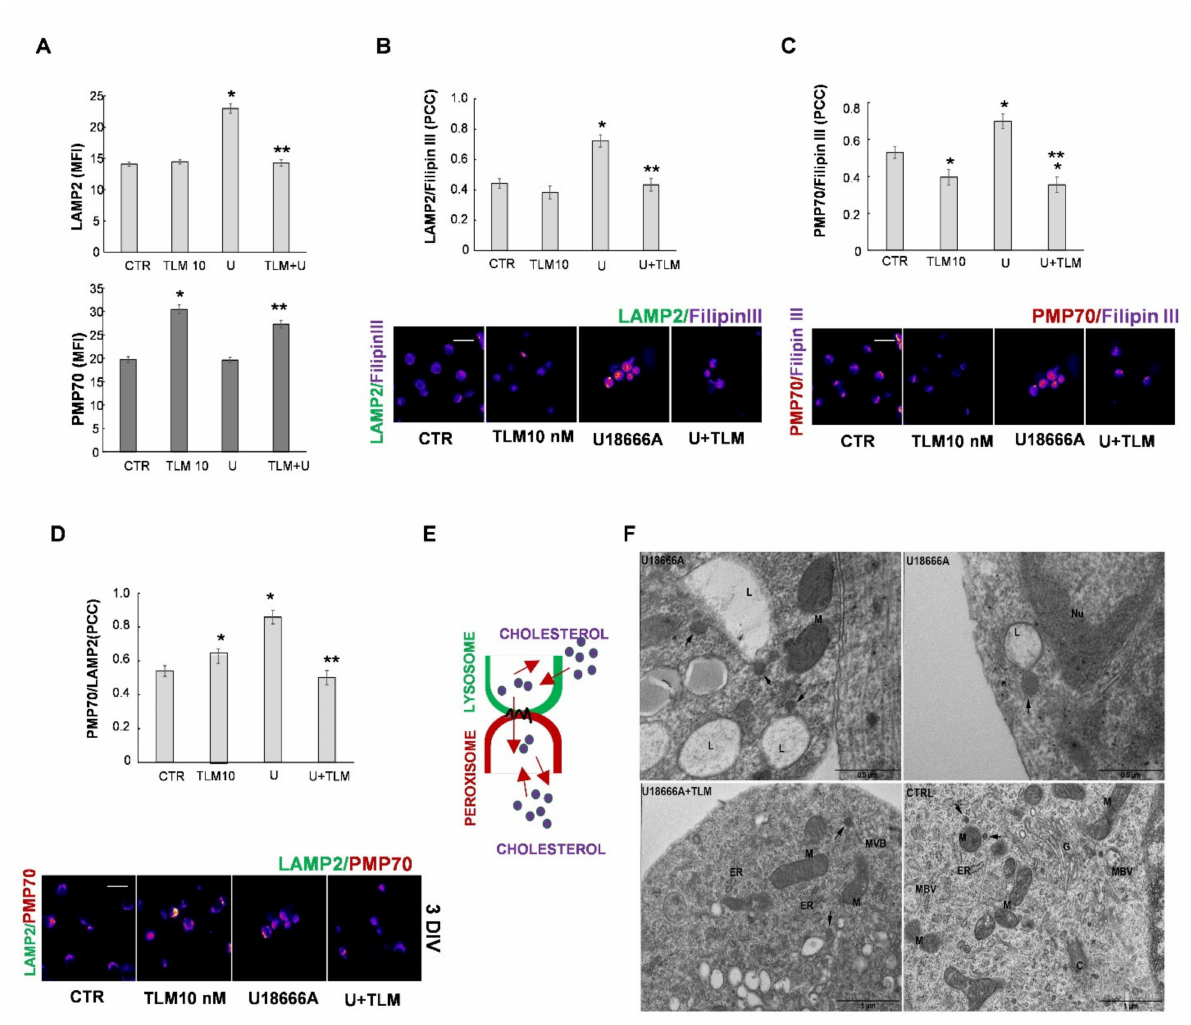
Figure 6. TLM modulates cholesterol traffic in lysosomes and peroxisomes. The lysosomal and peroxisomal levels were evaluated in OPs treated with TLM in the presence or absence of U18666A. The quantification of IF (MFI) of LAMP2 (lysosomal marker) and PMP70 (peroxisomal marker) is shown in ( A ). Data are Means ± SEM of 3 independent experiments (200–250 cells/condition; * p < 0.001 vs. CTR; ** p < 0.05 vs. U18666A, one-way ANOVA, unpaired two-tailed Student t -test). Colocalization of LAMP2/Filipin III ( B ) or PMP70/Filipin III ( C ) and LAMP2/PMP70 ( D ) were studied after 48 h of treatment with TLM 10 nM and/or U18666A (U). The photomicrographs evidence the localization of fluorescence signals captured and processed using ImageJ software, which reproduces the images according to a scale of arbitrary colors where the signal strength is proportional to the colocalization. Data are Means ± SEM of n = 3 (250–300 cells/field/condition). Scale Bar = 20 µ m. The bar graphs indicate the quantification of several colocalizations, expressed as the Pearson correlation coefficient (PCC). In ( E ), The cholesterol traffic (red arrow) between a peroxisome and lysosome is shown in a schematic diagram. ( F ) TEM micrographs of OP treated for 48 h with U18666A, U18666A and TLM or untreated (CTR) are shown. The images show lysosomes (L) or peroxisomes (arrows) in close contact after U18666A treatment. M = Mitochondrion; ER = Endoplasmic Reticulum; G = Golgi apparatus; C = Centriole; Nu = Nucleus; MVB = Multivesicular Body. Scale Bar = 0.5–1 µ